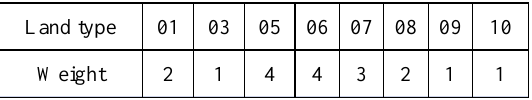
Table 1. Weight assignment of landscape utilization intensity. The land type codes are detailed in Figure 1.